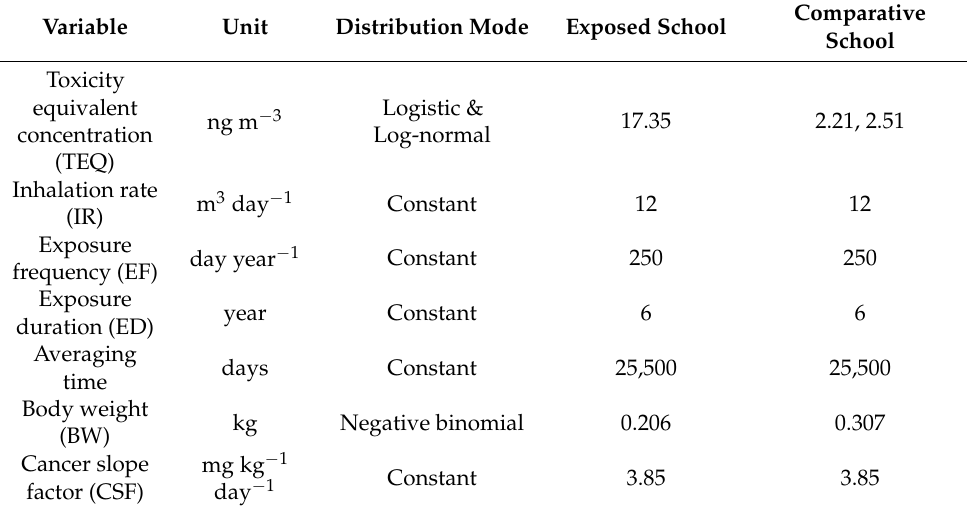
Table 1. Types of variable distribution used in the Monte Carlo